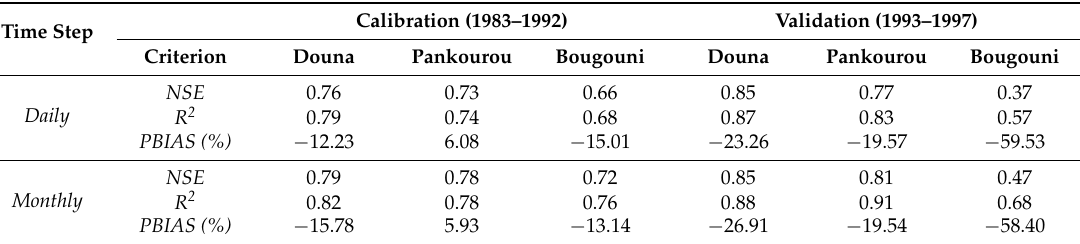
Table 3. Model performance statistics for the Bani catchment at Douna, Pankourou, and Bougouni discharge gauging